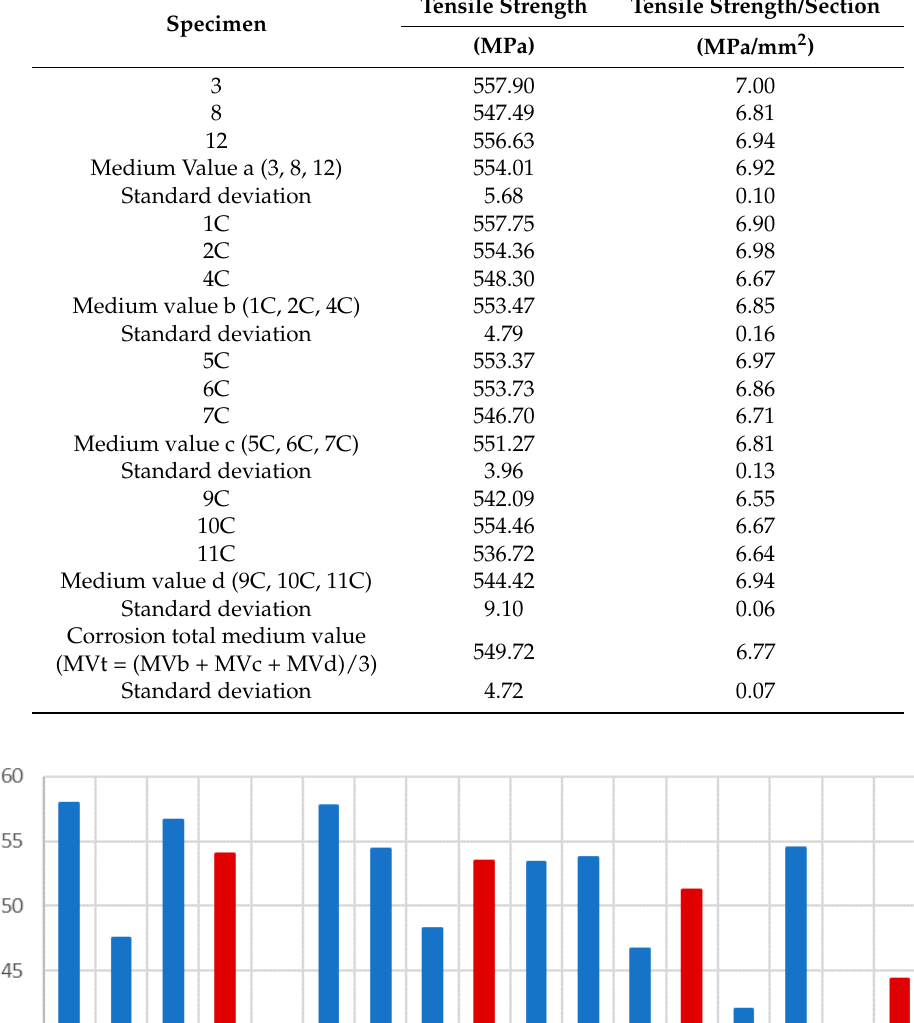
Table 5. Tensile strength and tensile strength/section relation values per specimen and medium values.